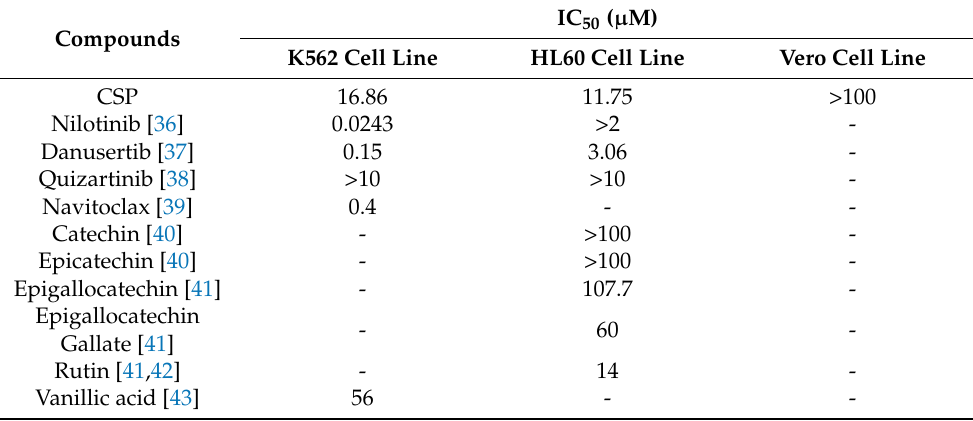
Table 1. IC 50 of the CSP extract, its components, and the reference molecules towards K562, HL60, and Vero cell